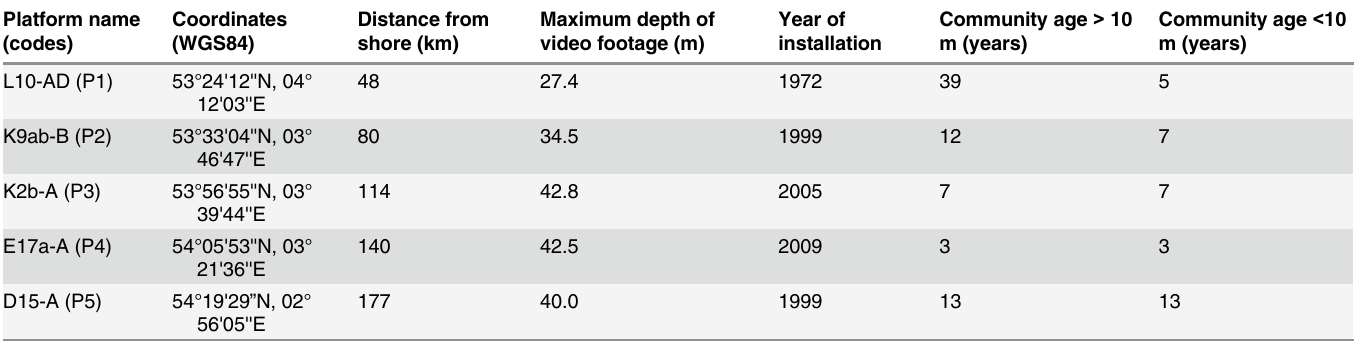
Table 1. Platform locations, distance from shore, maximum observed depths on the footage, year of installation of the platform, community age (years since last cleaning activities) at the time the video was recorded, for depths < 10 m > . Platform name